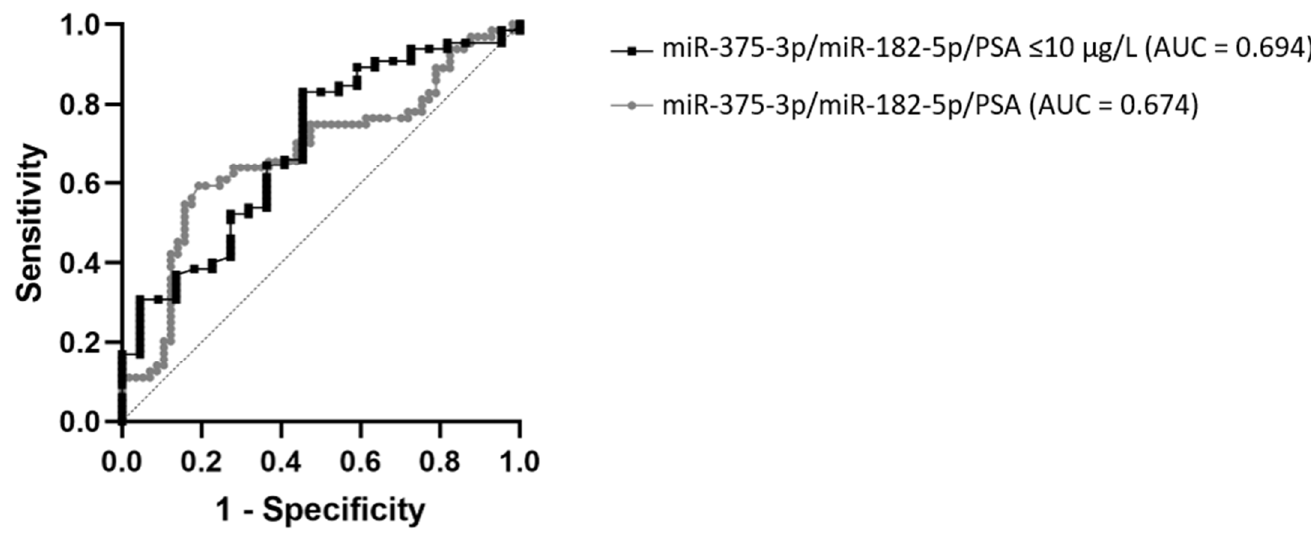
Figure 2. ROC curve analysis of the combinations miR-375-3p/miR-182-5p/PSA and miR-375-3p/miR-182-5p/PSA using sub-cohort of PCa patients with serum PSA levels ≤ 10 µg/L. is a figure.